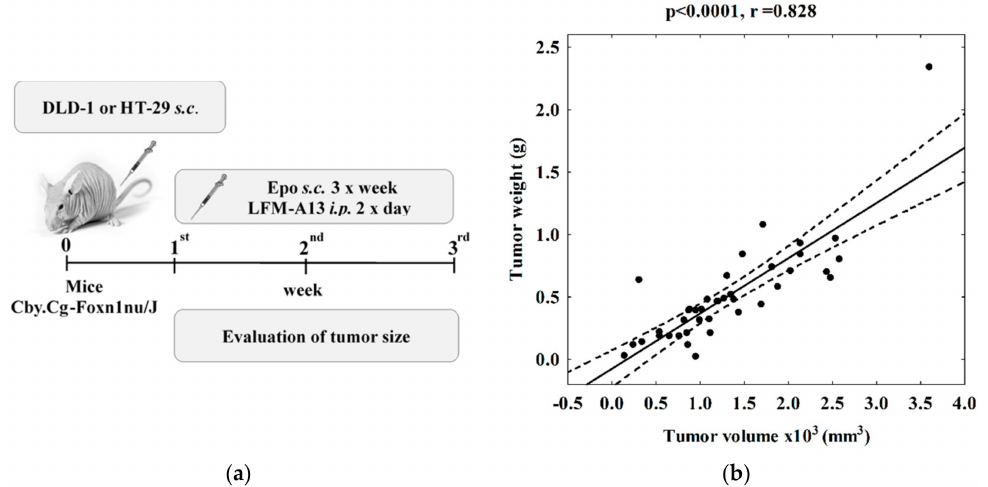
Figure 5. Human tumor xenografts in a nude mouse model. ( a ) Experimental plan. ( b ) Positive correlation between tumor volume and weight at mouse sacrifice ( p < 0.0001, r = 0.828). Solid line—regression; dashed lines—95% confidence intervals for regression